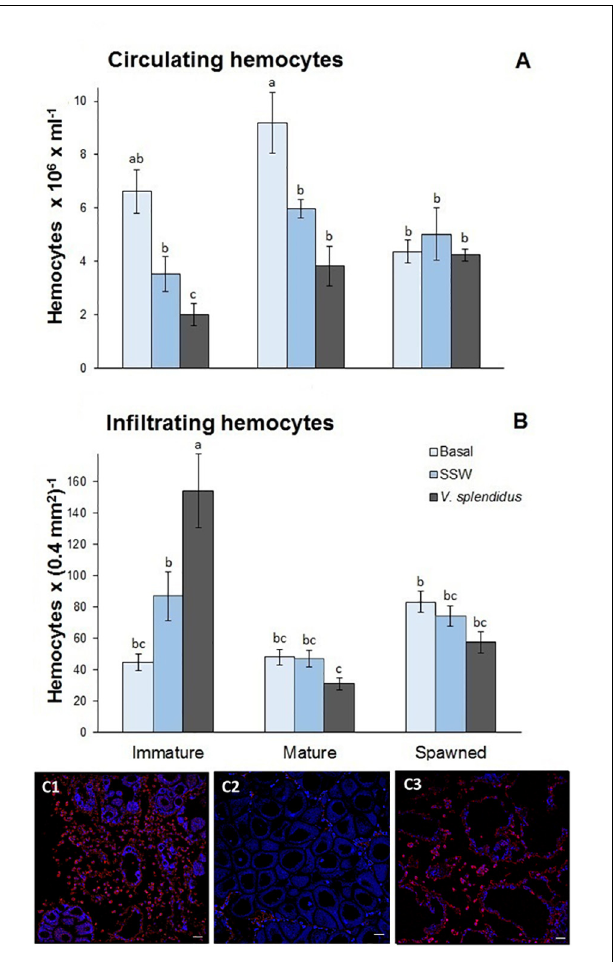
FIGURE 4 | Effects of in vivo challenge with V. splendidus on (A) the density of circulating hemocytes and (B) the number of the infiltrating hemocytes in immature, mature, and spawned A. purpuratus . Values associated with the same letter belong to the same subset based on a FDR-BY (false discovery rate) post hoc test (Benjamini and Yekutieli, 2001). (C) Representative images for the detection of infiltrating hemocytes in gonad tissue from V. splendidus -challenged scallops at different reproductive stages by immunofluorescence and confocal analysis. Alexa 568 goat anti-mouse antibody was used for hemocyte detection (in red) and autofluorescence was used as contrast (in blue). (C1) Immature; (C2) mature; (C3) spawned. Magnification 400X, scale bar: 25 µ m ( n = 4–8 per condition and